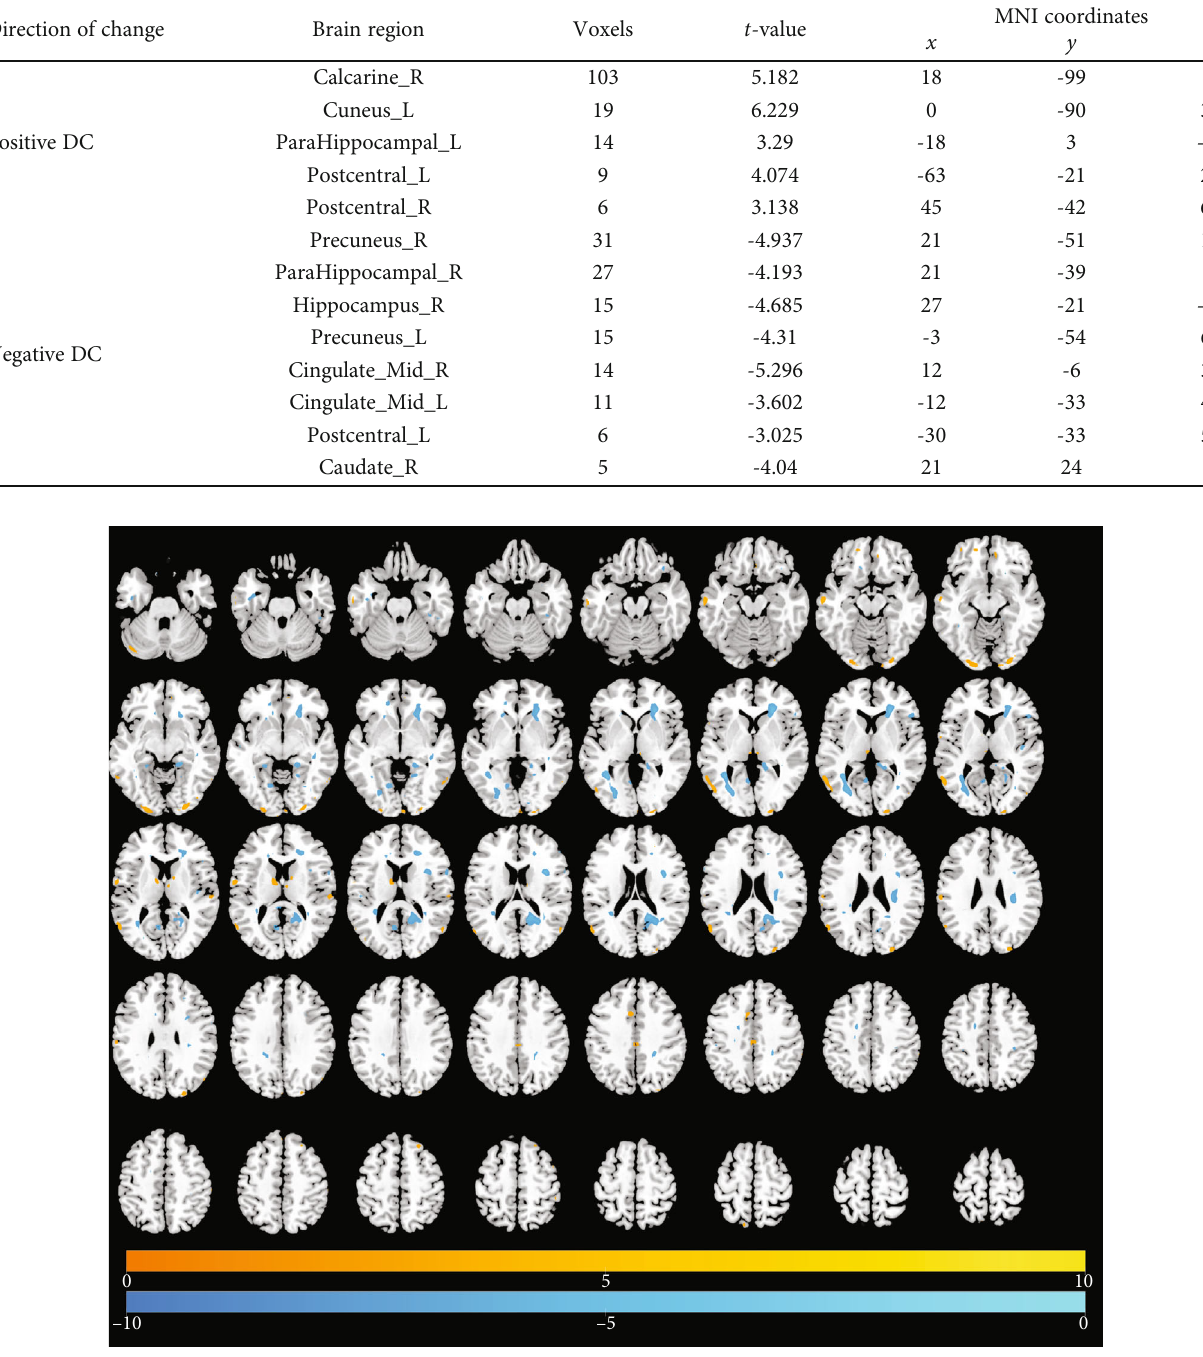
Figure 4: Di ff erences in the magnitude of DC between the same upper-limb amputee patients and control subjects at 2 months of rs-fMRI scan. Same conventions as in Figure